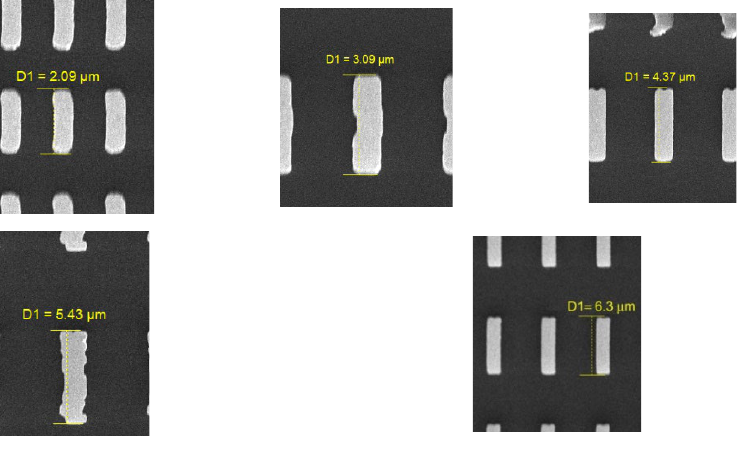
Figure 1. SEM images of gold dipole arrays from [19].